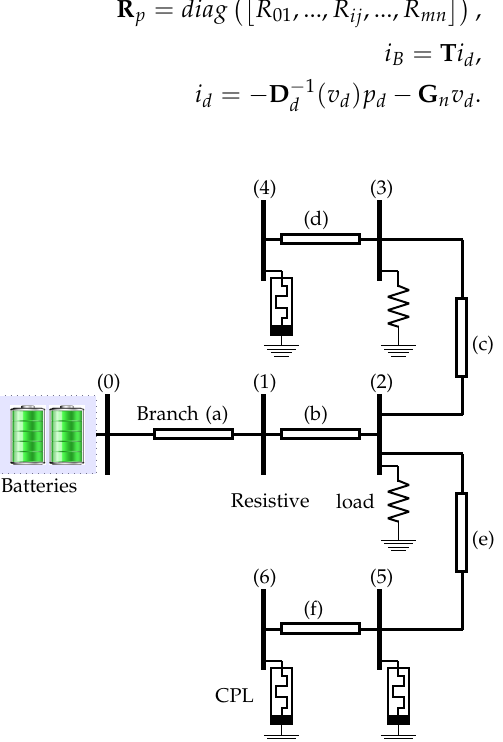
Figure 1. Radial direct-current (DC) electrical